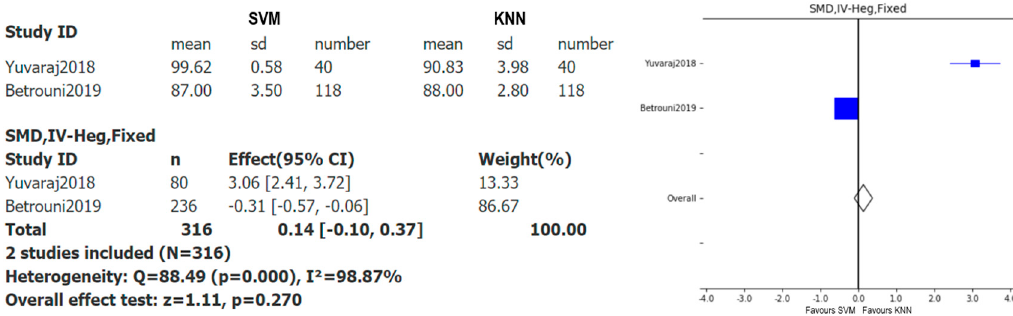
Figure 4. Forest plot with de standard mean di ff erence of the accuracy in both models, SVM and KNN, with the algorithm inverse variance Hedges’ adjusted g.